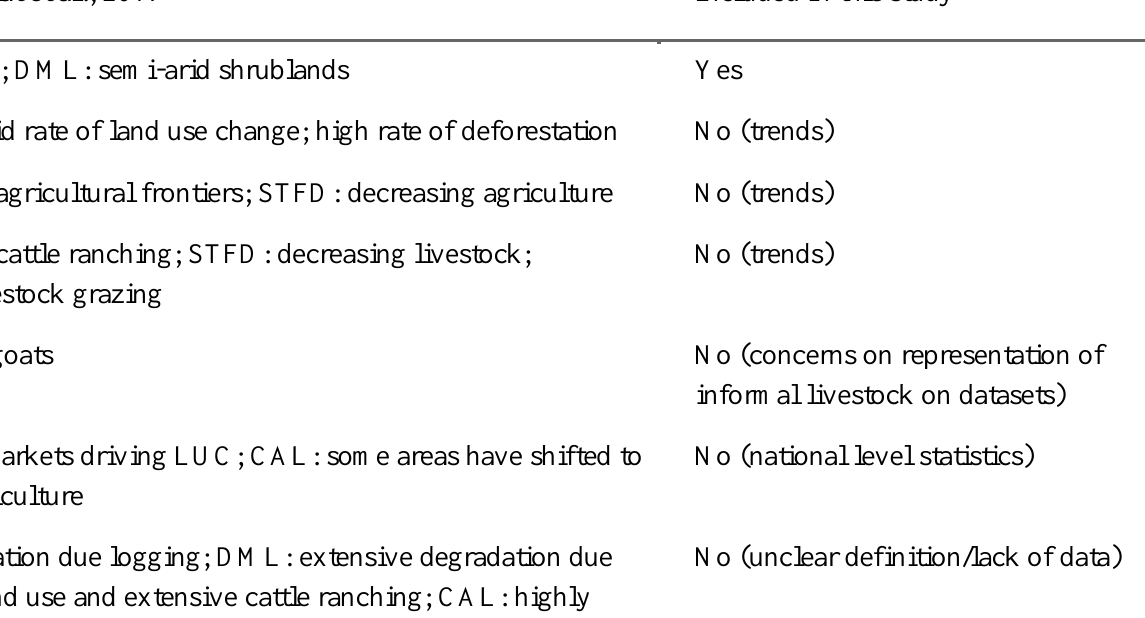
Table A1.1. Systematization process of the conceptual SELS’s descriptions: synthesis of all mentioned attributes into general variables. General